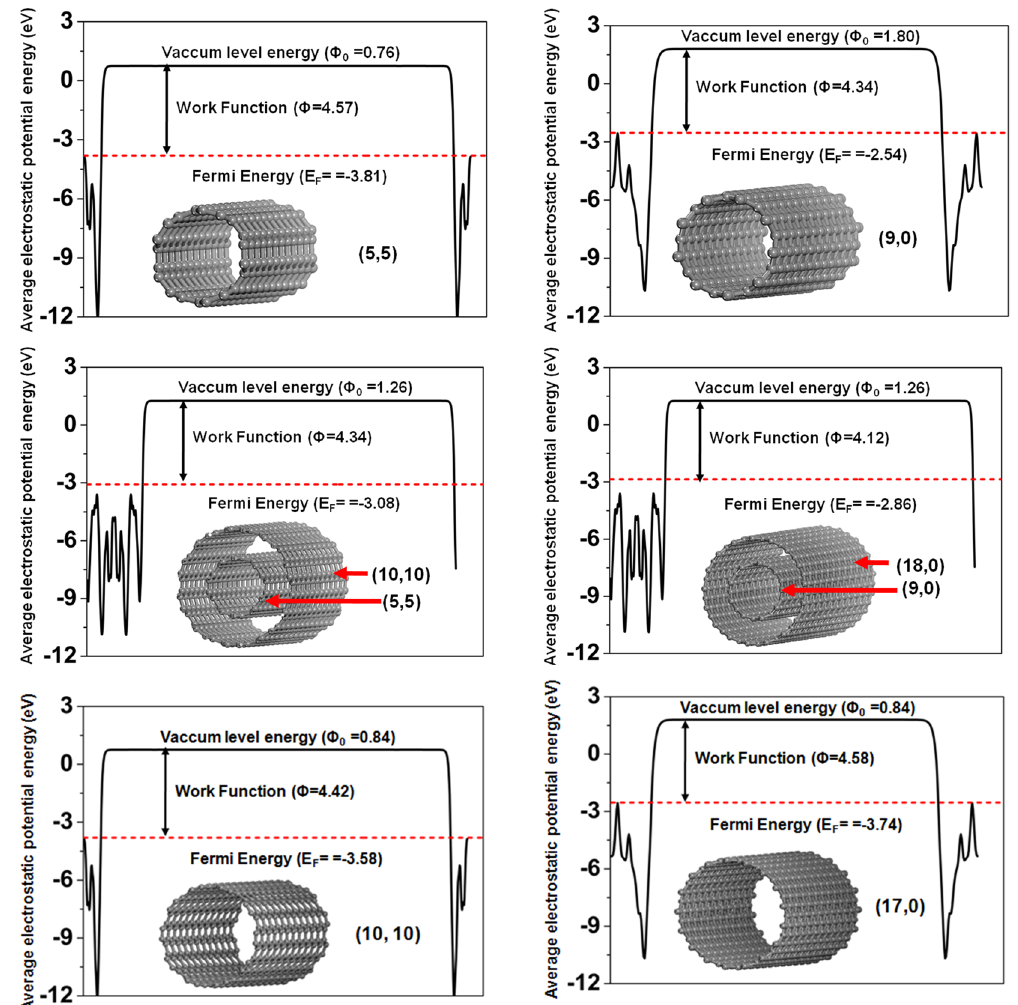
Figure 7. Calculated work functions of armchair-type single-walled CNTs (5, 5), (9, 0), zigzag-type single- walled CNTs (10, 10), (17, 0), and multi-walled CNTs (5, 5)/(10, 10), and (9, 0)/(17,